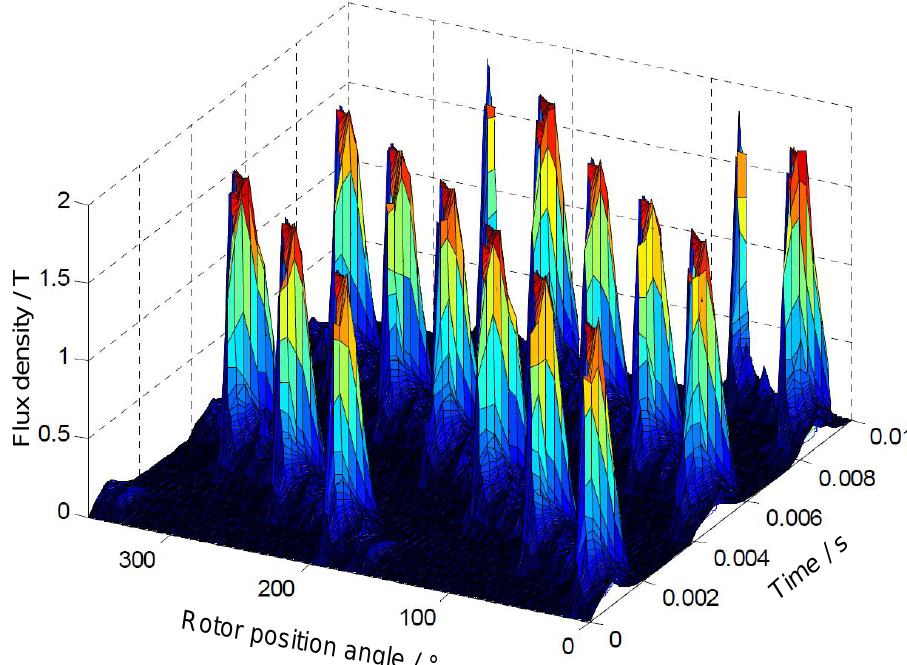
Figure 14. 3-D graph of flux density in the inner air